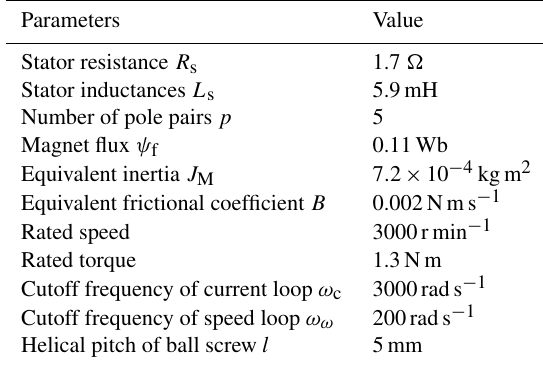
Table 1. Parameters of the servo system for the